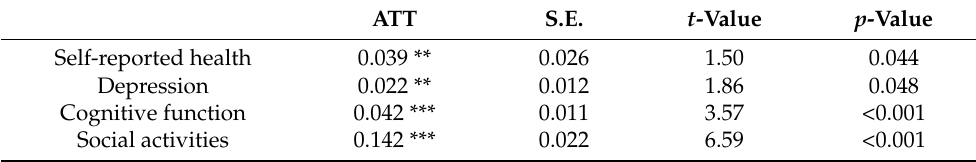
Table 6. Robustness analysis II (estimated by replacing outcome variables, nuclear matching).